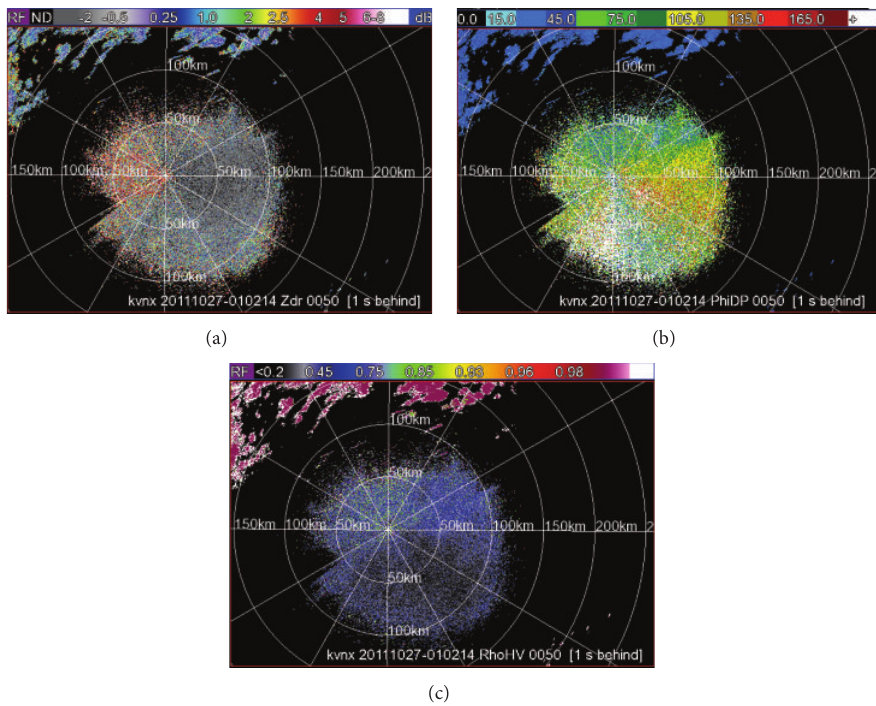
Figure 1: Imagers of (a) 𝑍 , (b) Φ , and (c) 𝜌 from the KVNX 0.5 ∘ scan at 0102 UTC (local time 8 pm) on 27 October 2011. The spatial DR DP hv resolutions of the original data are 250 min the radial direction and 0.5 ∘ in the azimuthal